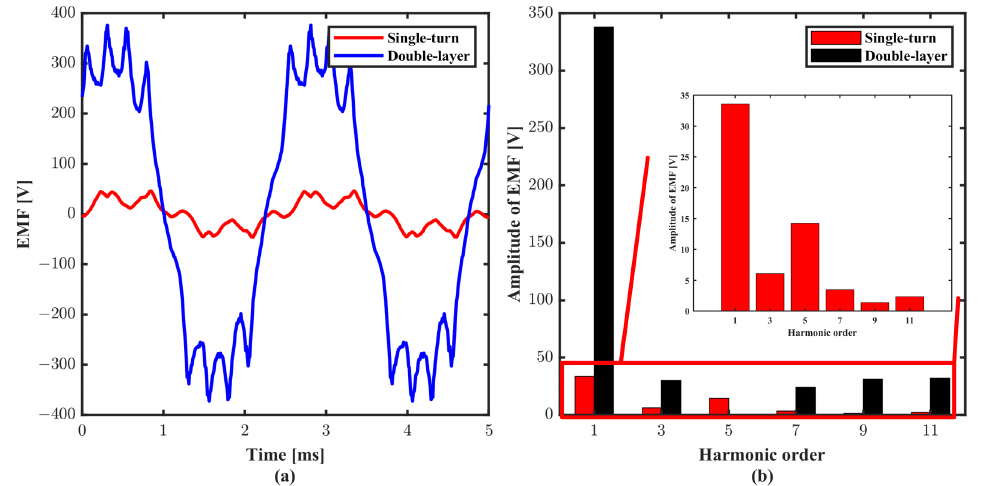
Figure 14. ( a ) The amplitude of EMF. ( b ) Harmonic analysis of